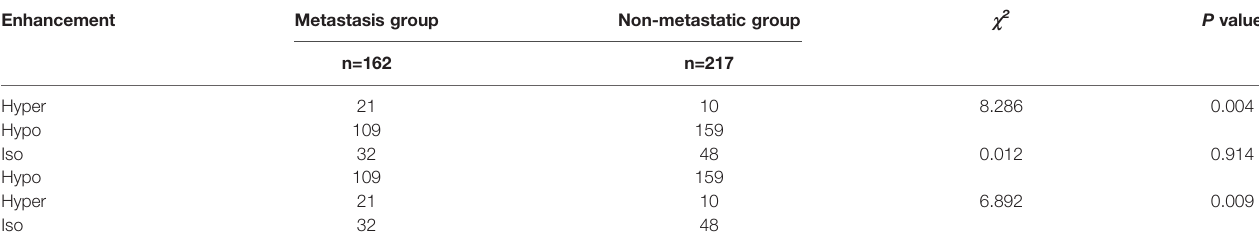
TABLE 4 | CEUS enhancement extent of PTCS in lymph node metastasis group and non-metastatic group.